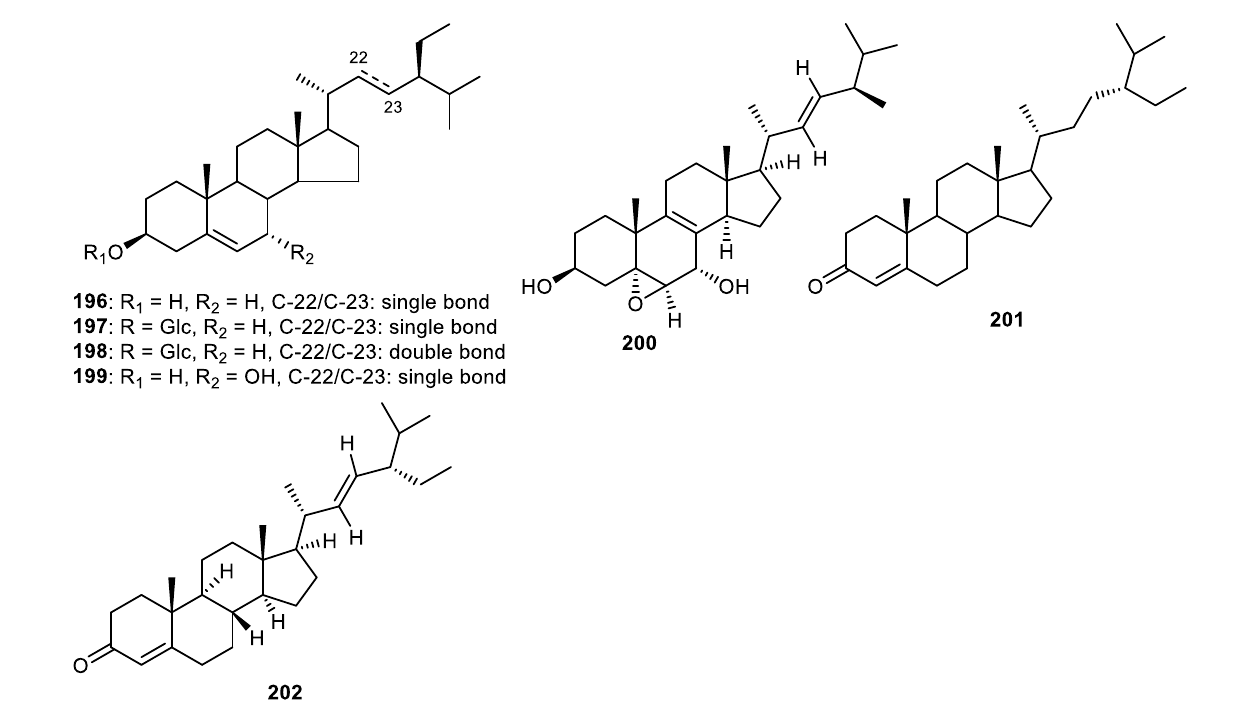
Figure 23. Structures of steroids 196 – 202 .